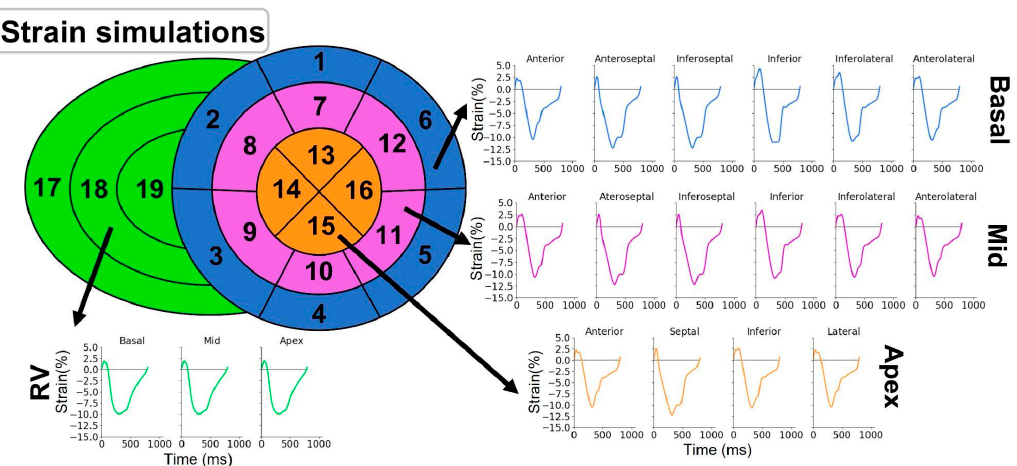
Figure 3. Strain simulations in baseline conditions. The presented strain curves correspond to the longitudinal deformation of each of the 16 left ventricular segments and 3 right ventricular segments during one cardiac cycle obtained after simulation of a healthy patient.